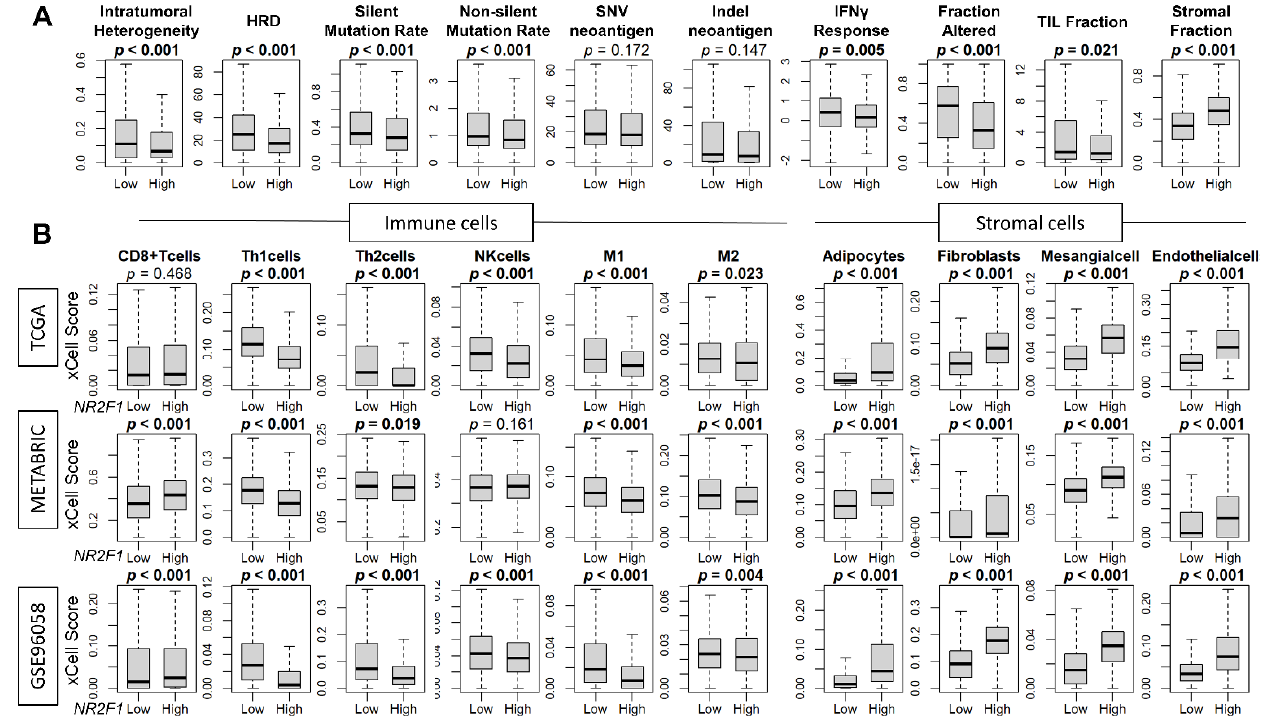
Figure 5. Association of NR2F1 with immunity within the tumor microenvironment. ( A ) Boxplots showing various scores based on high and low NR2F1 expression in TCGA. Intratumoral heterogeneity, homologous recombination deficiency (HRD), silent/non-silent mutation rate, SNV/Indel neoantigen, interferon gamma response, fraction altered, tumor-infiltrating lymphocytes (TIL) frac- tion, and stromal fraction. ( B ) Boxplots showing immune and stromal cell fractions between NR2F1 high and low groups in three large cohorts. Mann–Whitney U test was used to compare the two groups, and p values are shown in bold for significant results ( p < 0.05).